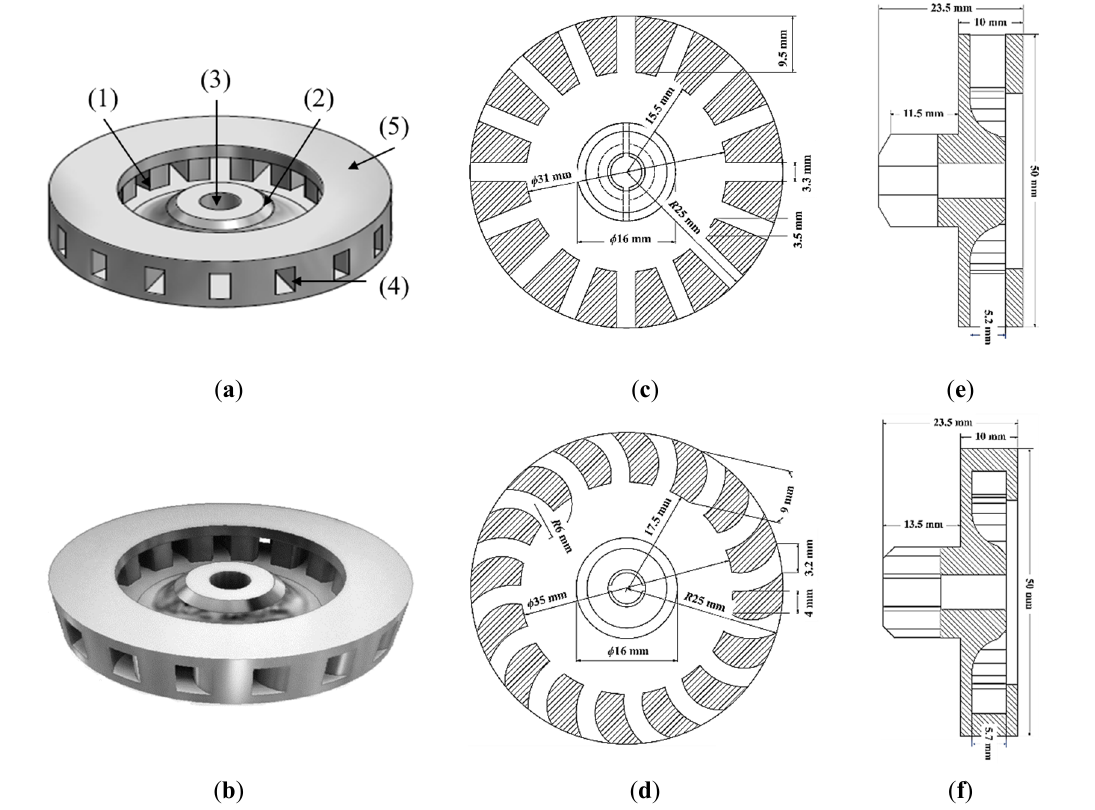
Figure A3. Shape and dimensions (absolute error of ± 0.1 mm) of the atomization discs ( a , b ) form and structure; ( c , d ) interior view; ( e , f ) side view of the straight rectangular vanes disk and the curved rectangular vanes disk, respectively.